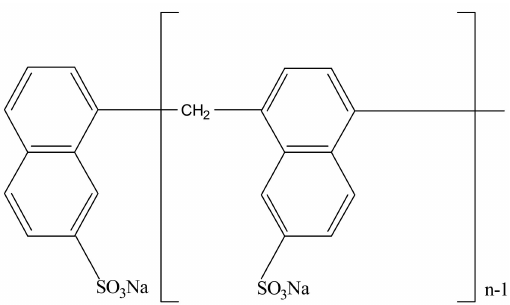
Figure 1. Chemical structural diagram of sulfonated naphthalene formaldehyde (SNF) condensate.